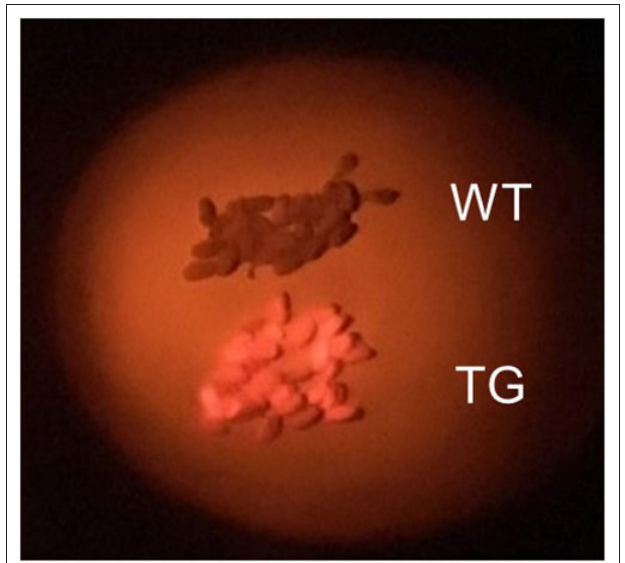
FIGURE 2 | Selection of transgenic Camelina seeds. Wild-type (WT) Camelina seeds appear brown and transgenic (TG) seeds containing DsRed appear orange-red when photographed using a green LED and a red filter in the